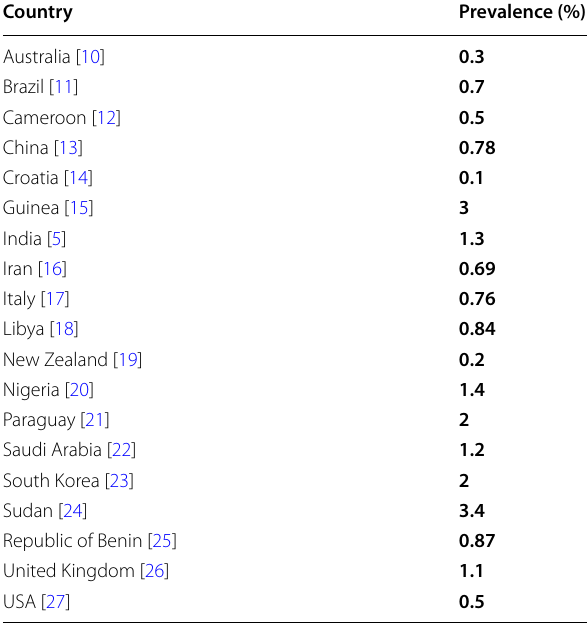
Table 1 Physiological effects of thyroid